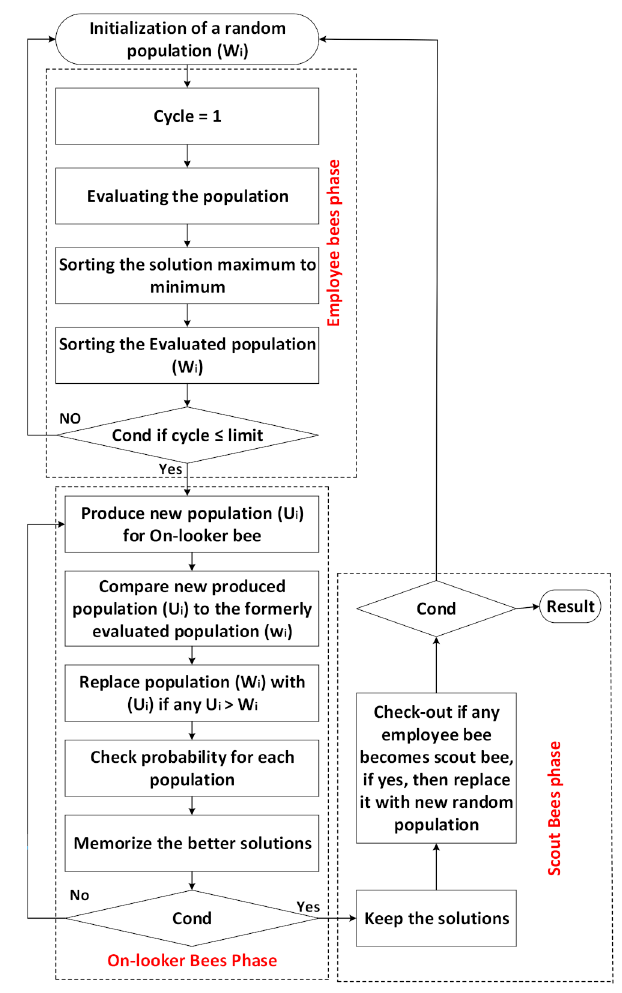
Figure 5. A flowchart of the Artificial Bee Colony (ABC)